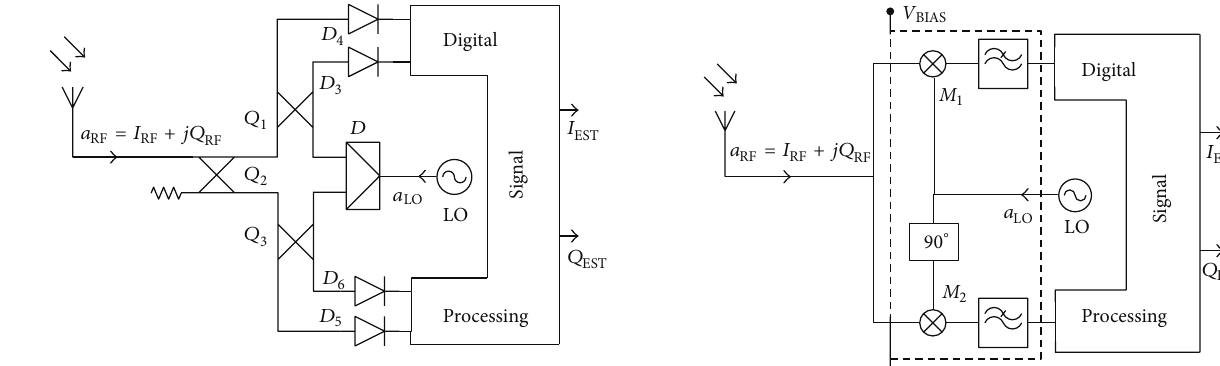
Figure 1: A typical architecture of receiver front-end using six-port technique.